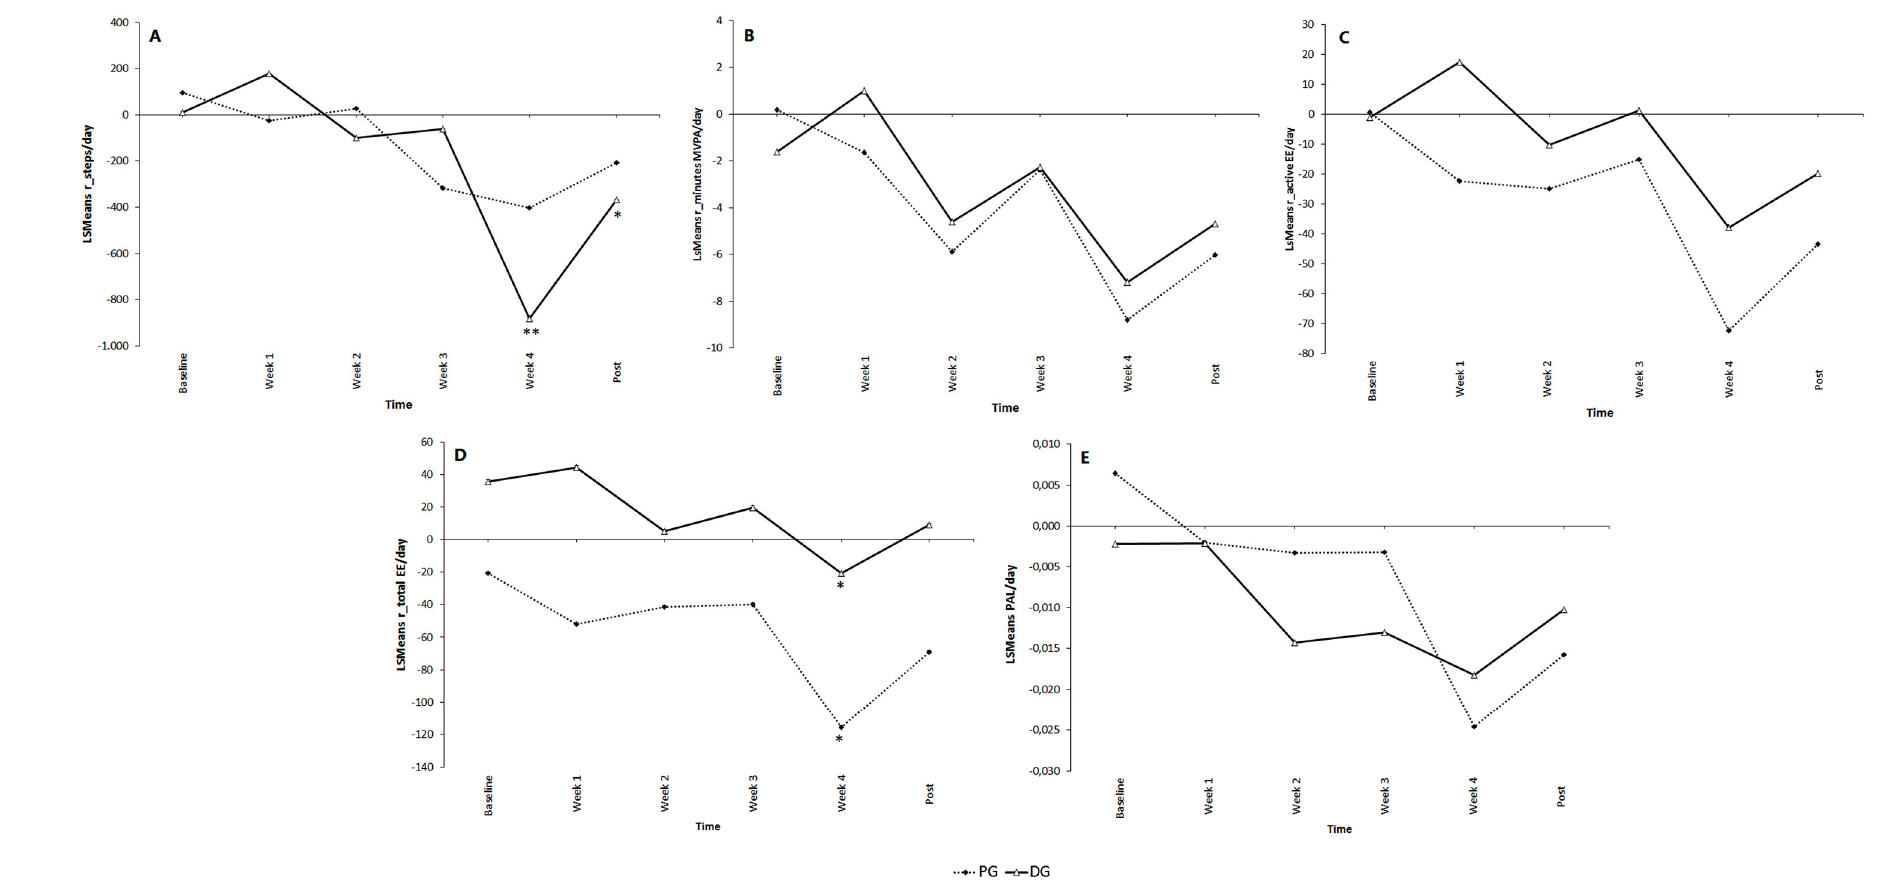
Figure 4. Residuals for steps ( A ); minutes of moderate to vigorous physical activity ( B ); total energy expenditure ( C ); active energy expenditure ( D ) and physical activity level ( E ) at baseline, week 1, week 2, week 3, week 4 and post 1 for the Pedometer Group (PG) and the Display Group (DG). Data are expressed as least square means (LSMeans). Within subject effects are shown. An asterix (*) indicates a significant difference to baseline measurement within the PG and DG; * p < 0.05; ** p < 0.01. Key: PA: Physical Activity; EE: Energy